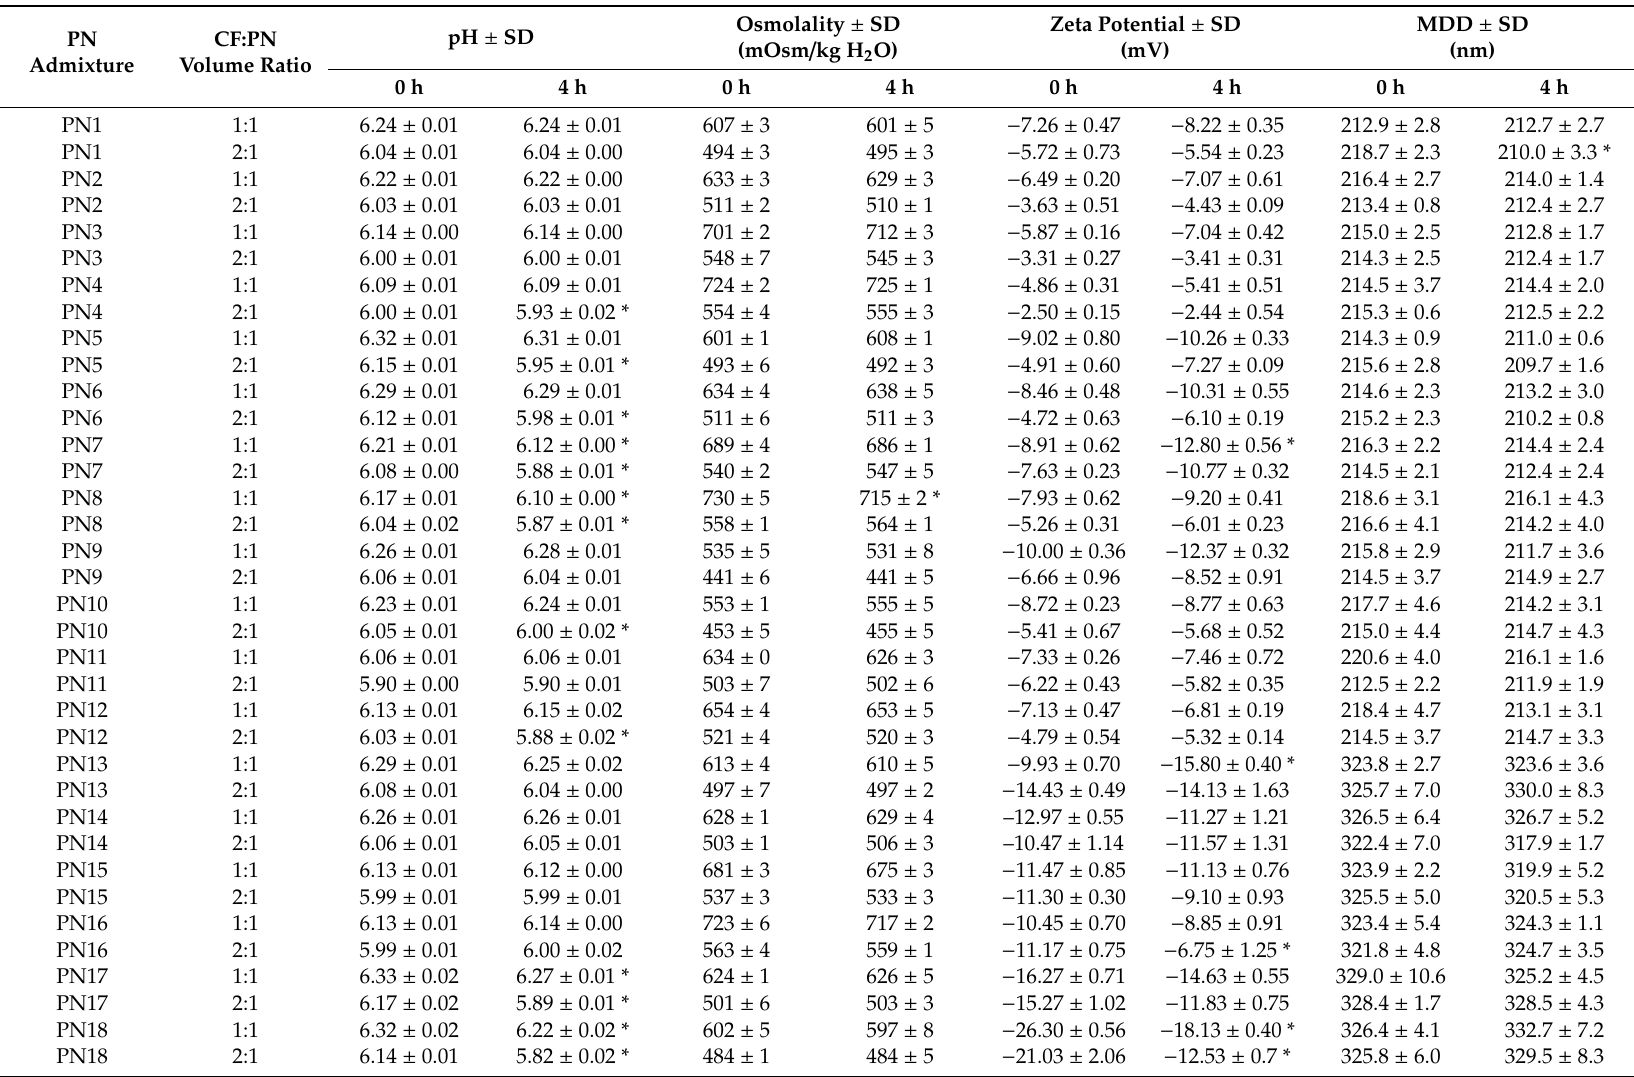
Table 3. Results of pH, osmolality, zeta potential, and particle size of CF–PN